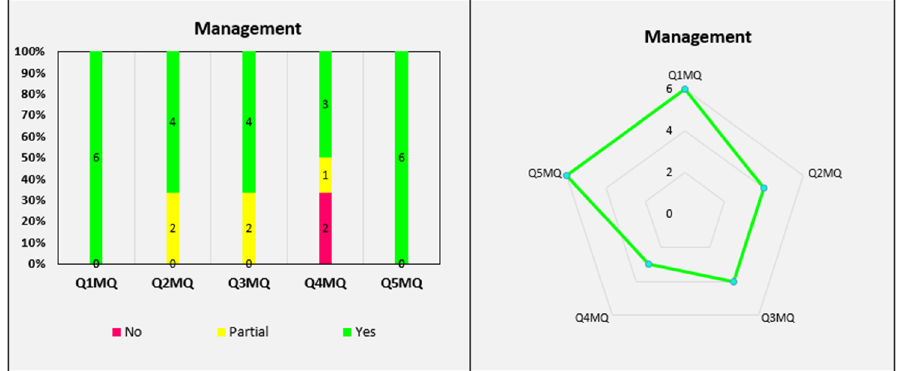
Figure 9. Answers regarding the management criteria.